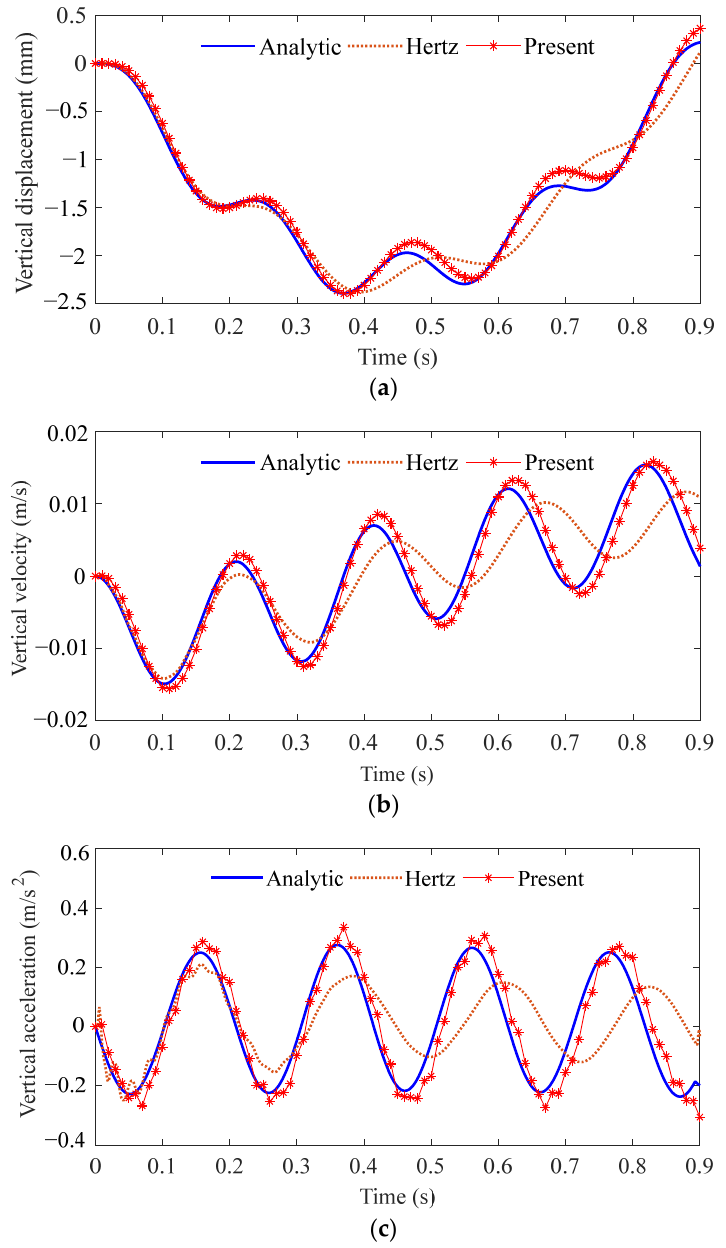
Figure 3. Comparative results for the time history curve of the mid-span of the bridge: ( a ) vertical displacement, ( b ) vertical velocity, and ( c ) vertical acceleration.